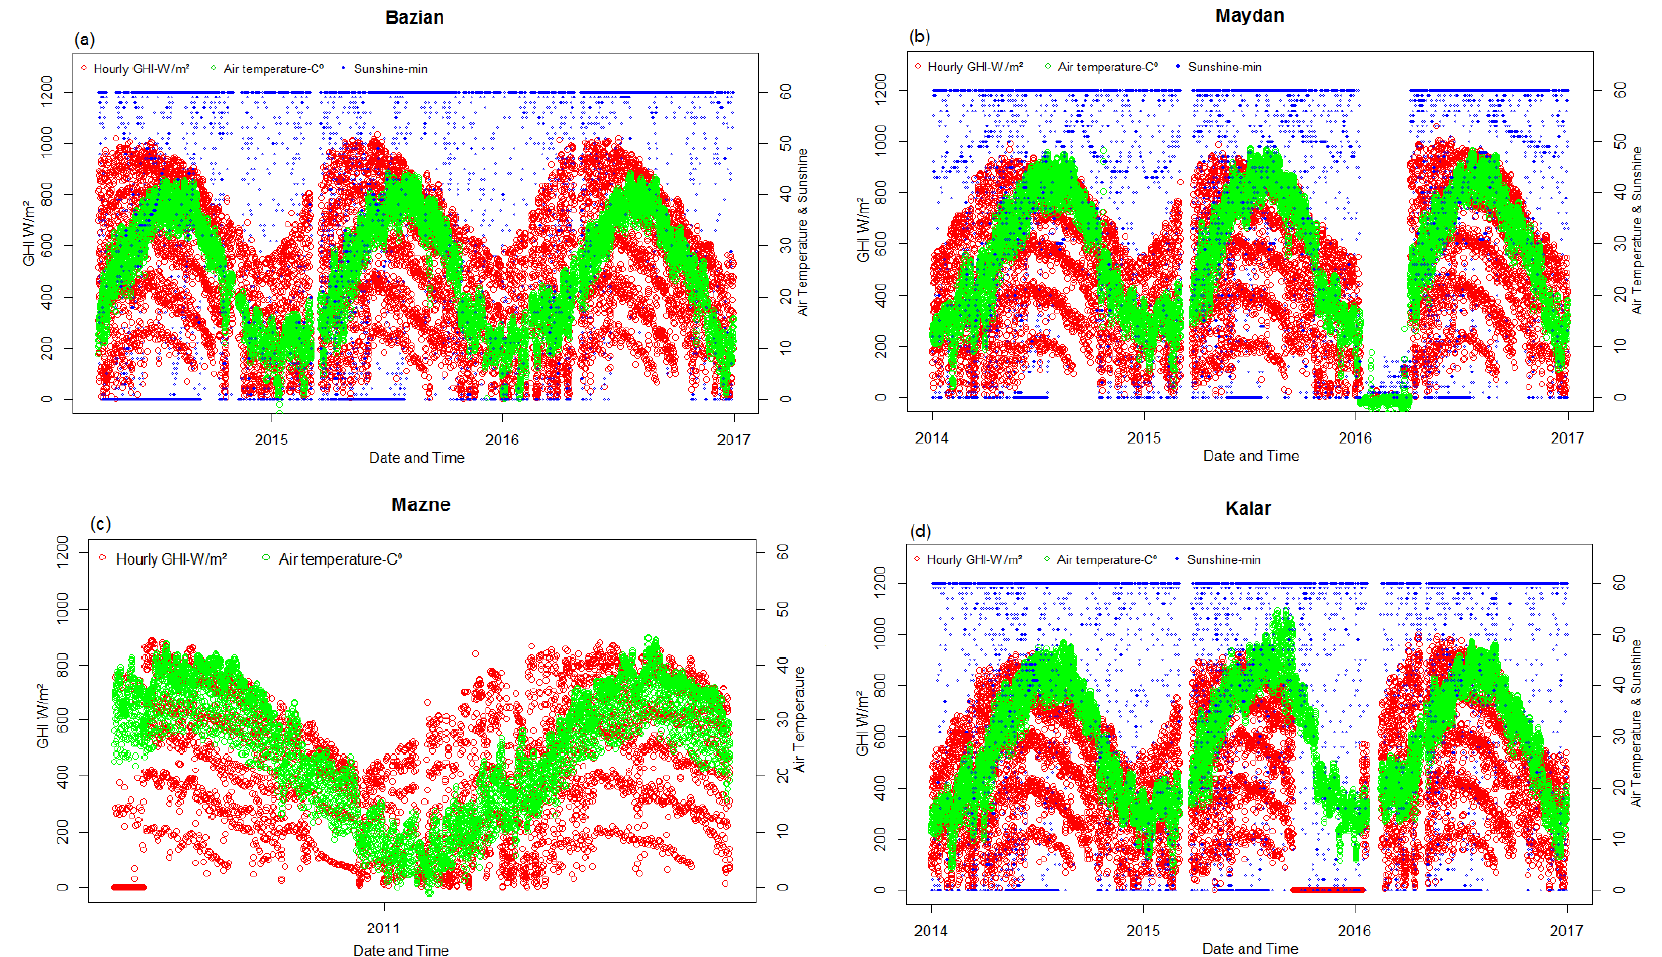
Figure 3. Scatterplots of GHI W/m 2 (first y-axis) and SD in minutes per hour with AT in ◦ C (second y-axis) for all-time series hourly data at stations namely ( a ) Bazian, ( b ) Maydan, ( c ) Mazne which SD is unavailable, and ( d ) Kalar.